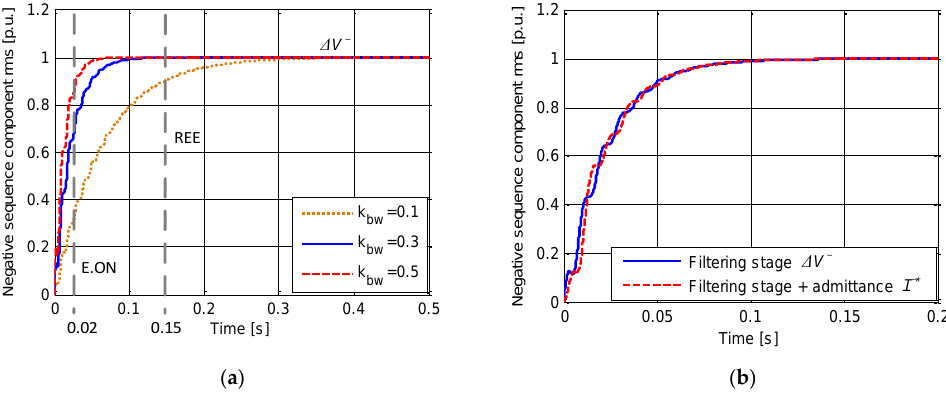
Figure 4. The time response of: ( a ) the sequence filtering stage of the virtual admittance block under different values of k bw ; and ( b ) the virtual admittance block when k bw = 0.3.